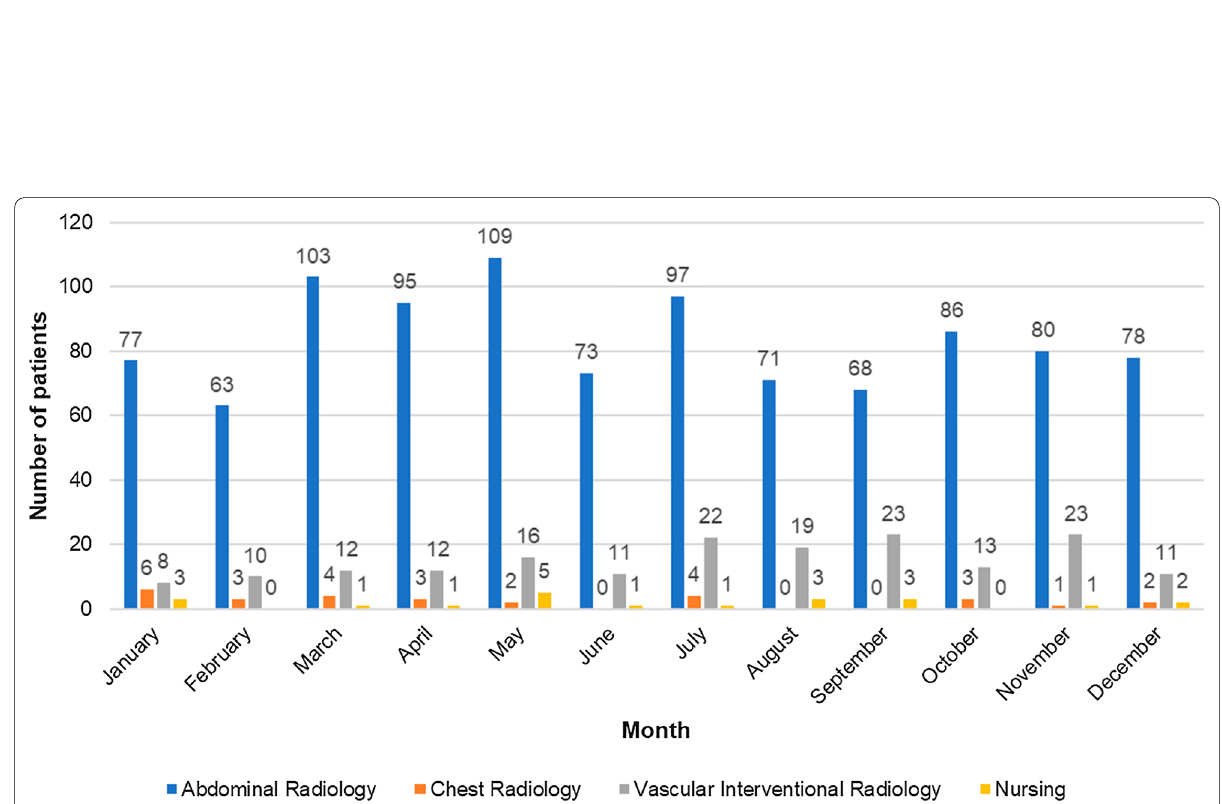
Fig. 2 Admitted patients in the Radiology Day Unit in 2019. Number of patients admitted to the Radiology Day Unit during 2019 distributed by the corresponding section including the procedures performed exclusively by the nursing staff (i.e., CT colonography